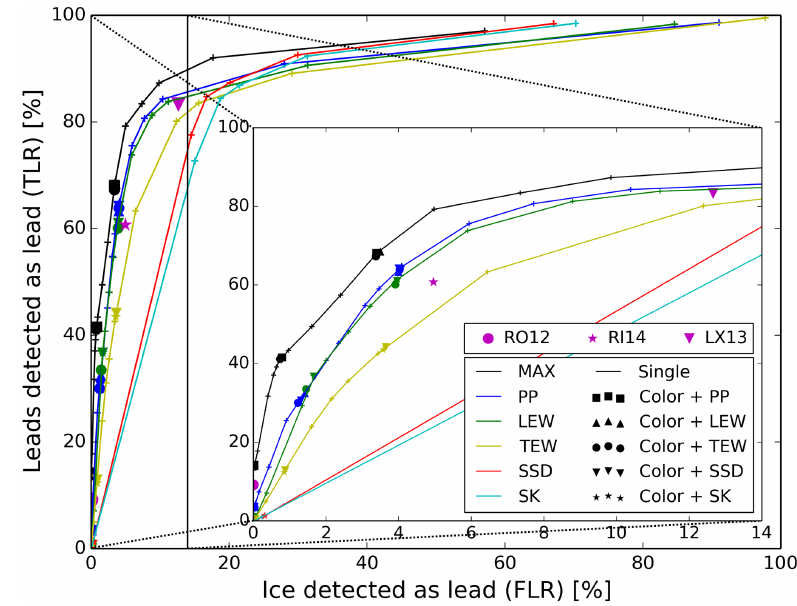
Figure 4. ROC graph of tested classifiers with altering thresholds ( (cid:50) ) on one (connected by lines) and two (marker) parameters as well as predefined classifiers (magenta markers). RO12 corresponds to the classifier used in Röhrs et al. (2012). In the two-dimensional case, the color indicates one of the parameters, and the shape the other one. The inset is a zoom of small false lead